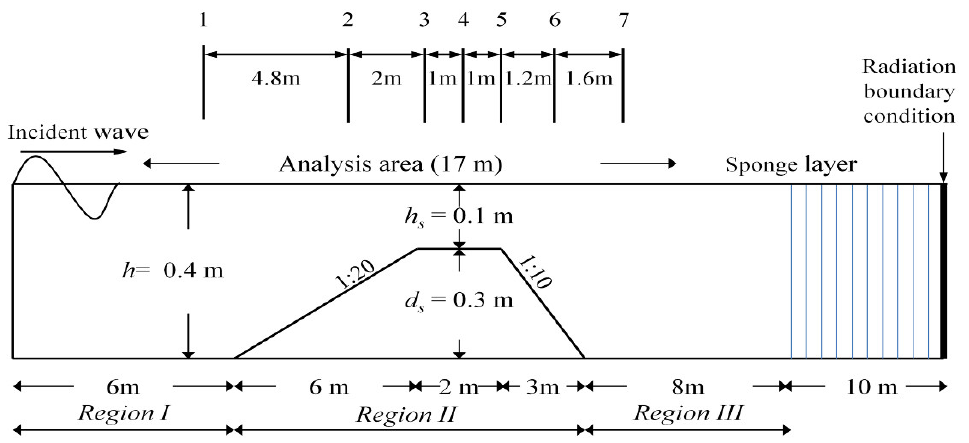
Figure 3. Illustration of the experiment set up of [48] for periodic wave propagation over a submerged bar.